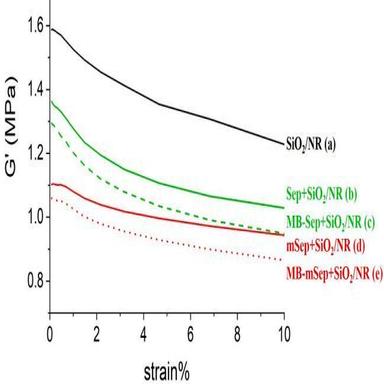
Loss modulus G′ vs strain of SiO2/NR (a, black line), Sep+SiO2/NR (b, green line), MB-Sep+SiO2/NR (c, green dashed line), mSep+SiO2/NR (d, red line), MB-mSep+SiO2/NR (e, red dotted line). (For interpretation of the references to colour in this figure legend, the reader is referred to the web version of this article.)